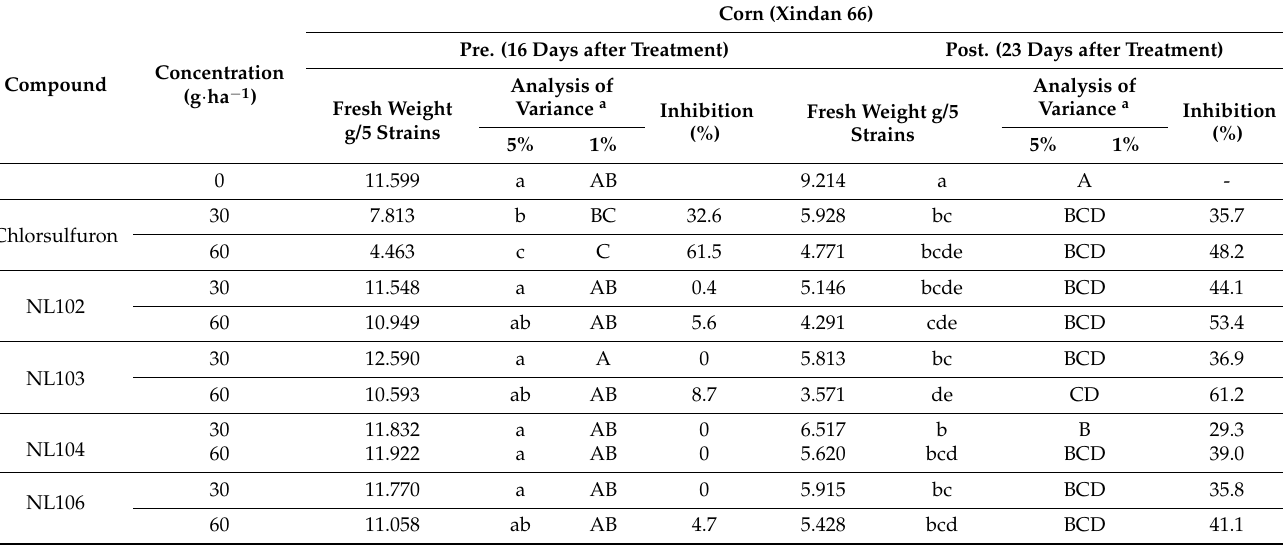
Table 5. Crop safety of target compounds on